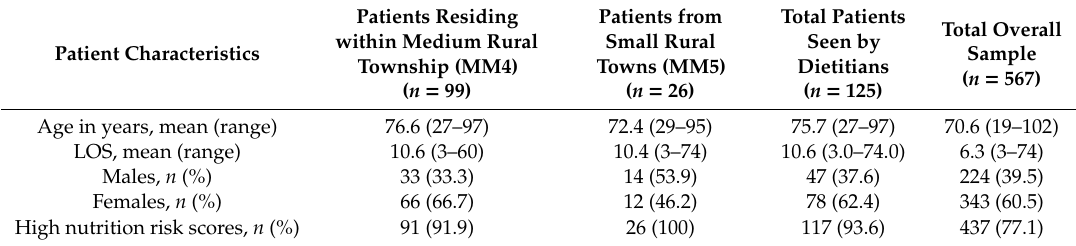
Table 2. Demographics and screening characteristics of all patients assessed by a dietitian by